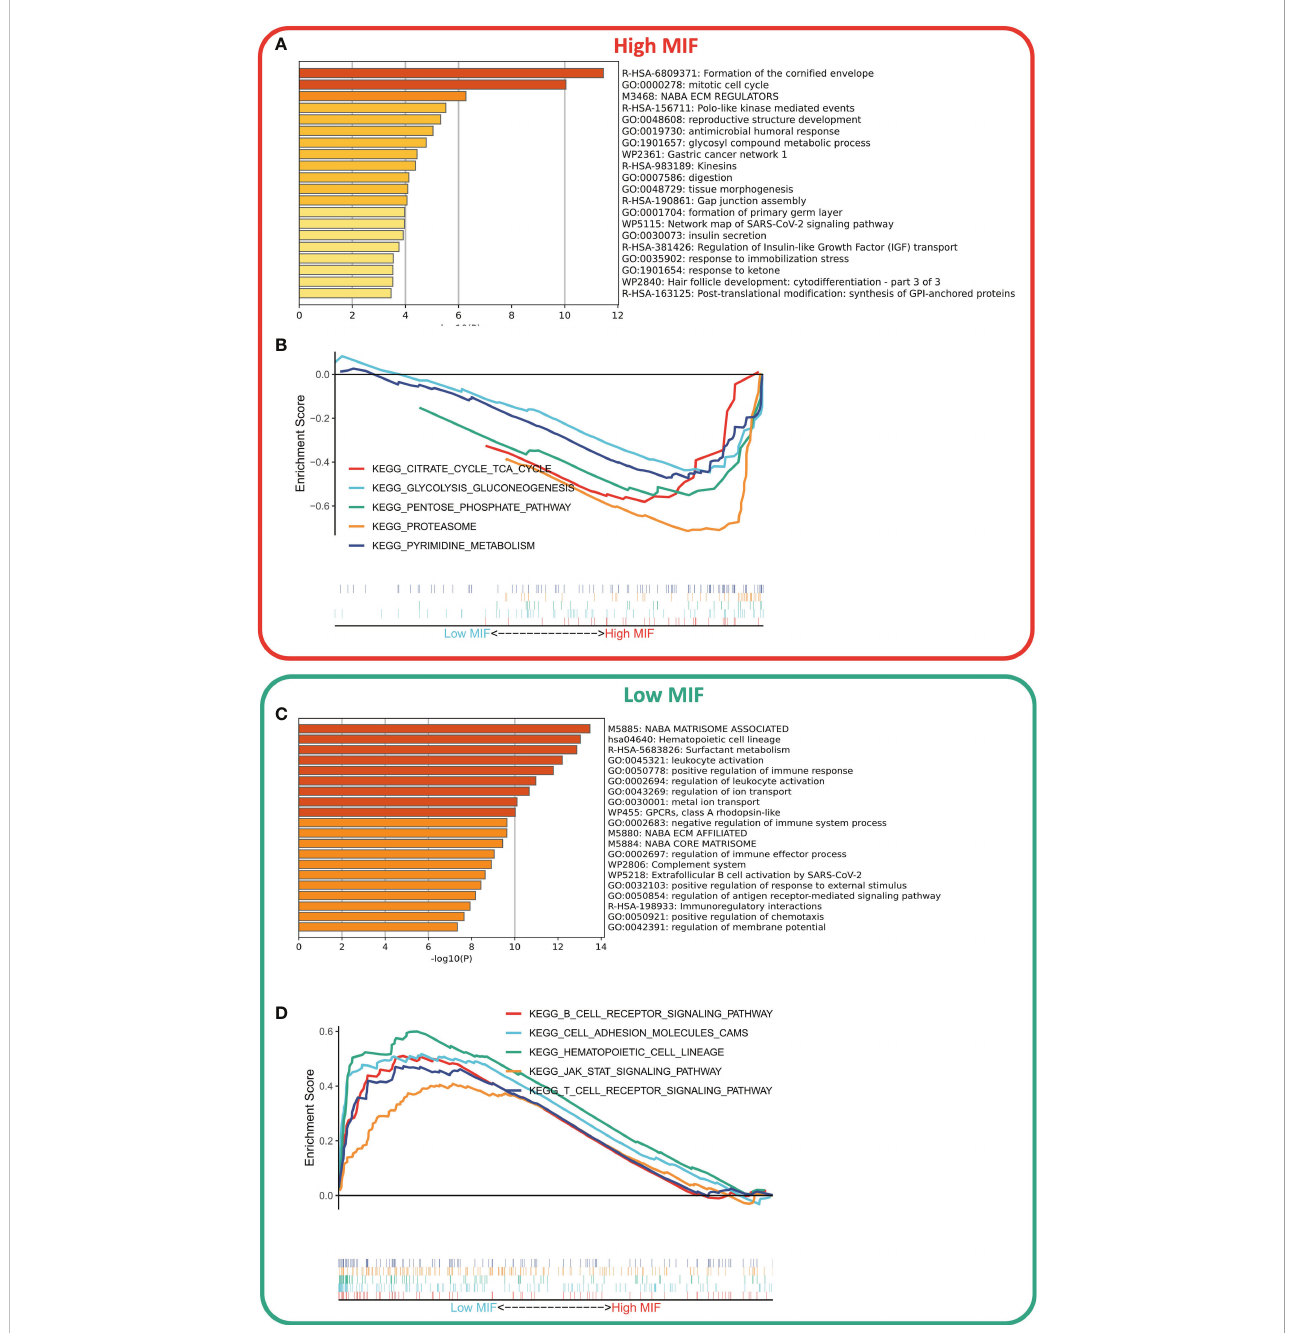
FIGURE 6 Differences in biological functions of the two subtypes. (A, C) GO analysis of high- and low-expressed genes. Functional enrichment analysis showed that the upregulated genes in the high MFI group mainly regulated cell cycle and Gap-linked pathways (A) , while the upregulated genes in the low MFI group mainly regulated hematopoietic cell lineage, in fl ammatory responses, cell adhesion and lymphocyte migration (C) ; (B, D) KEGG analysis of high and low-expressed genes. The enriched pathways in the high MFI group were TCA cycle pathway, pentose phosphate pathway, proteasome, and glycolytic pathway (B) . In contrast, the pathways that were enriched in the low MFI group are mainly B-cell receptors, T-cell receptors and Jak-stat signaling pathways, as well as hematopoietic cell line-related pathways (D)